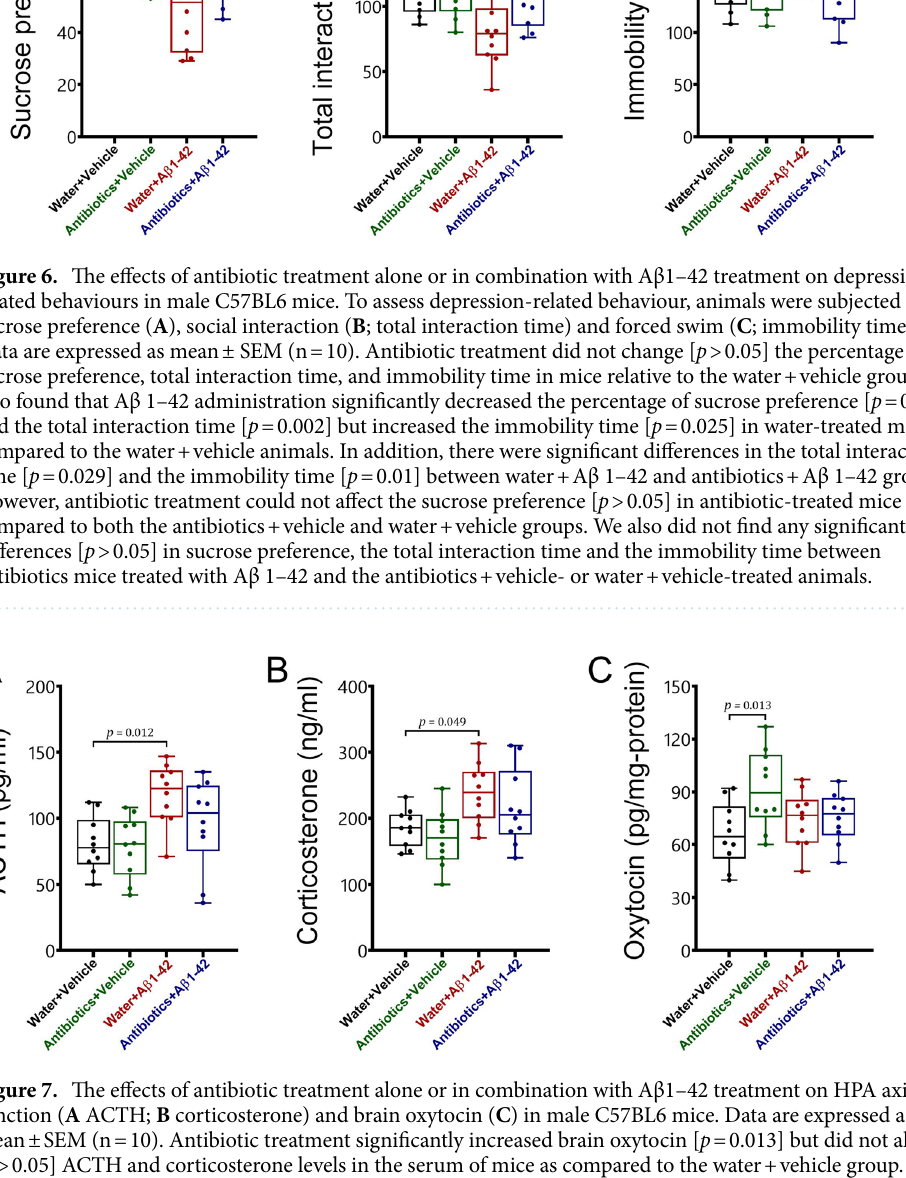
of mice and the brain areas. A strong connection exists between brain oxytocin and HPA axis function 73–75 . Brain oxytocin inhibits the basal and stress-induced activity of the HPA axis in male and female rats 73,74 . Although